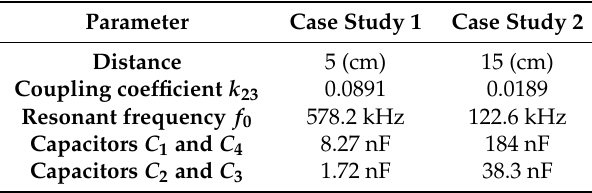
Table 4. Test case